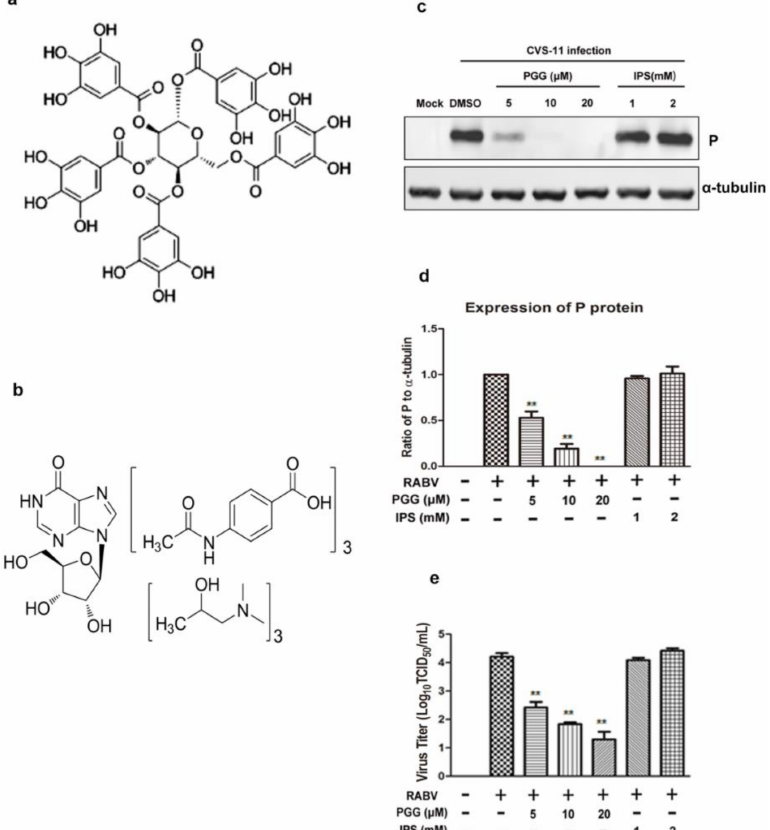
Figure 1. PGG directly inactivates rabies virus (RABV). Chemical structure of ( a ) 1,2,3,4,6-penta- O - galloyl- β - D -glucopyranose (PGG) and ( b ) isoprinosine (IPS). After incubation with PGG and IPS, RABV was inoculated with BHK-21 cells for 48 h, and ( c ) the expression level of viral P was analyzed by Western blotting. ( d ) The relative expression levels of viral P, normalizing to that of α -tubulin. ( e ) The virus titers of culture supernatants were determined by TCID 50 assay and plotted. (** p <